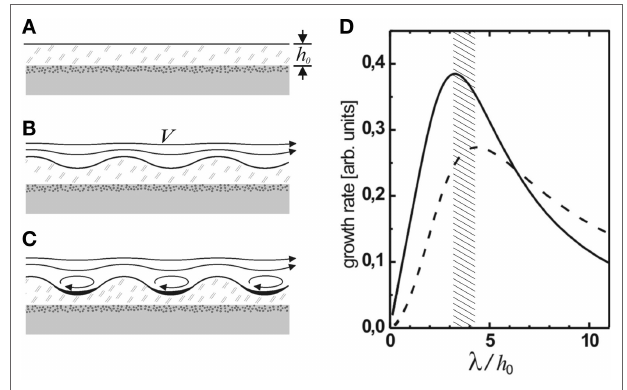
FIGURE 5 | (A–C) Schematic representation of the generation of Kinneyia-type ripples from a hydrodynamic instability (HI). The microbial mat grows in a quiescent environment and is then subject to significant flow in the overlying water (A) . This results in a HI, which gives rise to a ripple pattern at the surface of the mat (B) . Once the amplitude of the ripple reaches a certain threshold, eddies will form in the valleys giving rise to stagnation points and enhanced sedimentation (C) . Rupture of the film can occur when the amplitude of the troughs becomes comparable to the film thickness. (D) The predicted relative growth rate of the ripple pattern is sharply peaked around a dominant wavelength of 3.2 to 4.3 times the film thickness h 0 [adapted from Thomas et al. (2013) with